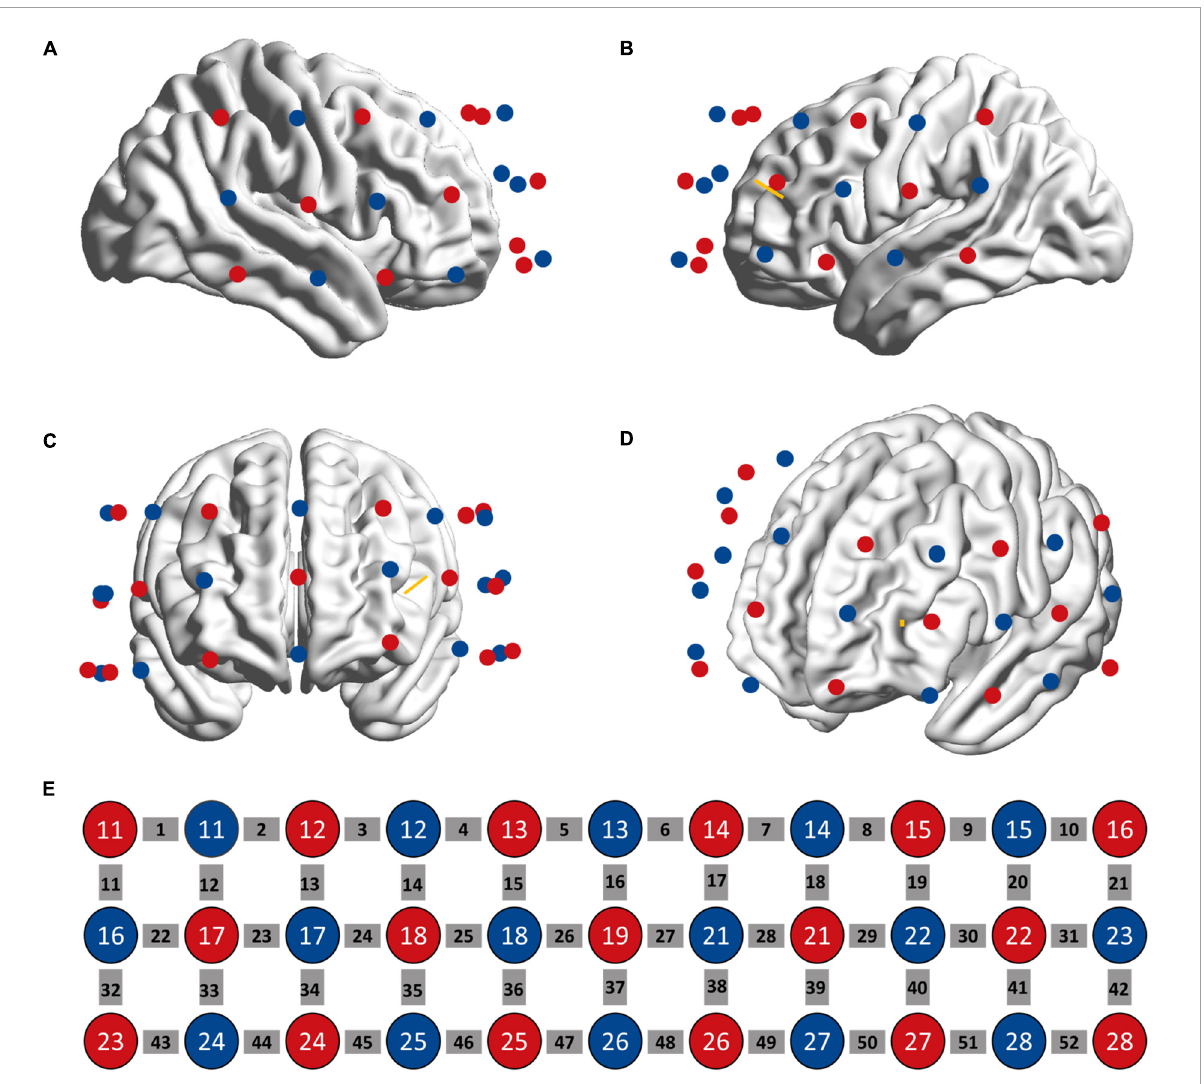
FIGURE2 Location of fNIRS sources (red circle) and detectors (blue circle) on the head as seen from the right (A) , left (B) , anterior (C) , and left frontal (D) perspectives. (E) The sources and detectors were laid out in a 3*11 configuration. The gray squares represent measuring channels. The yellow bar denotes the projection of stimulation